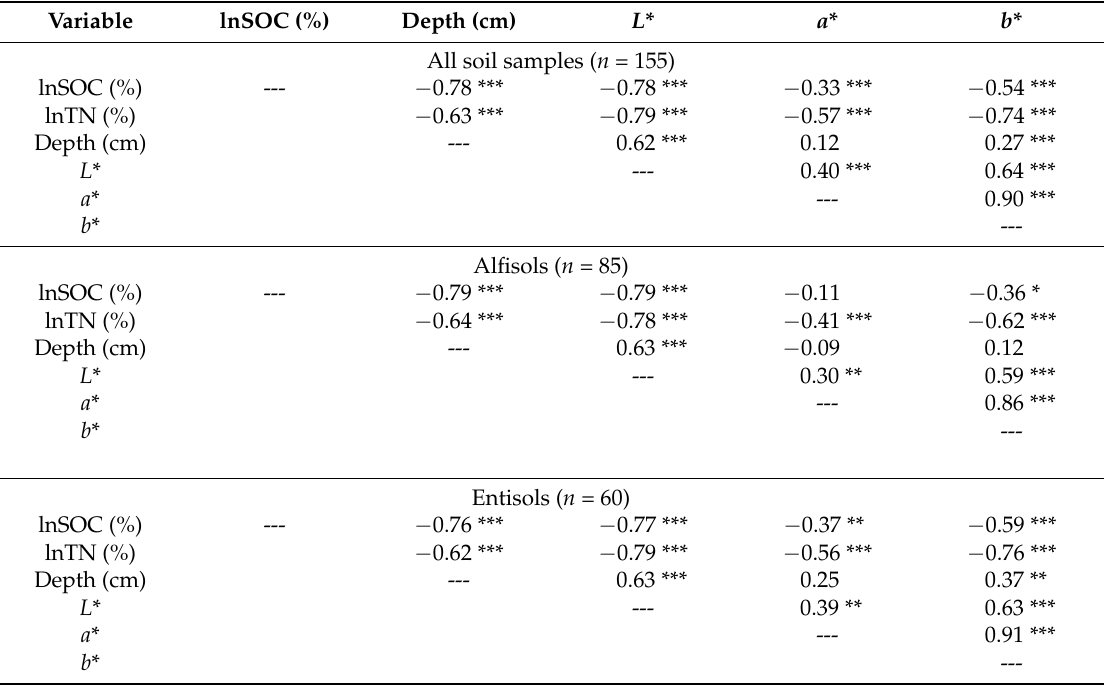
Table 2. Pearson correlation ( r ) values among soil variables for the lnSOC (%) analysis for all soil orders, Alfisols, and Entisols for the soil set